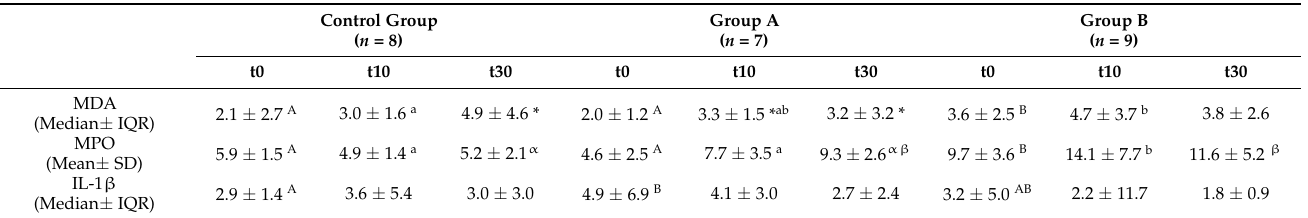
Table 6. Plasma concentrations of MDA, MPO and IL-1b of adult women subjected to cryolipolysis on one (group A) or multiple areas of the body (group